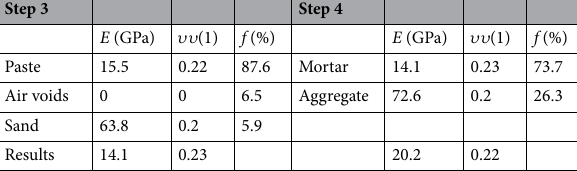
Table 4. The homogenization step 3 and 4 of the multi-scale